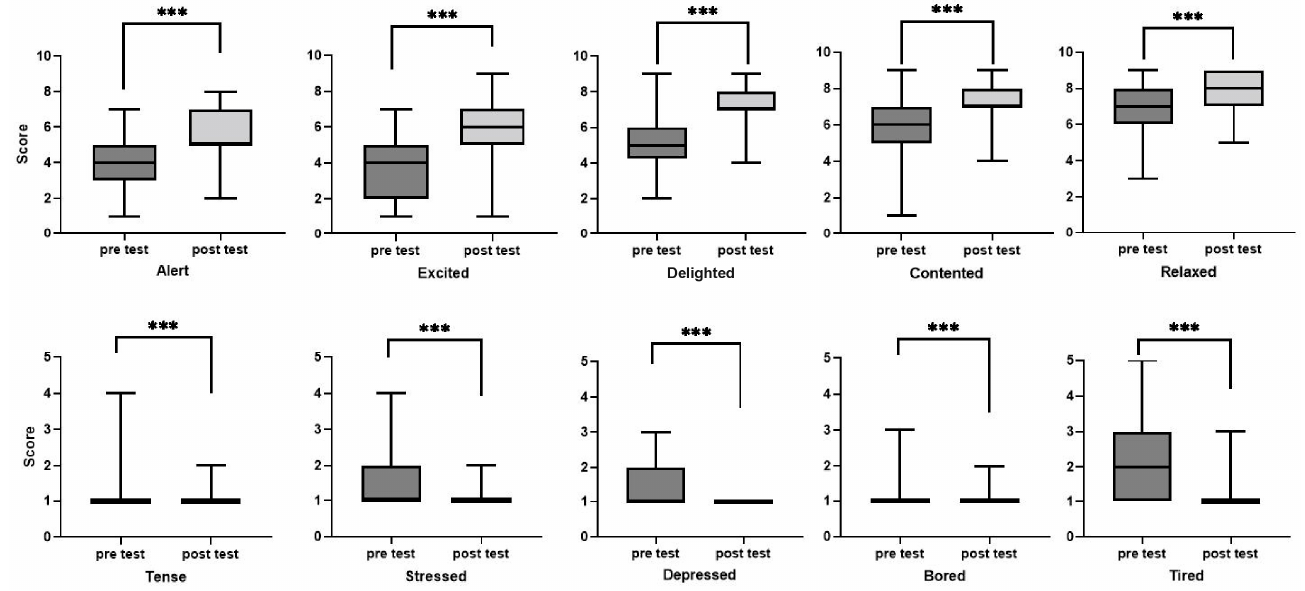
Figure 5. Box chart of winter emotion test results. (*** p < 0.01).